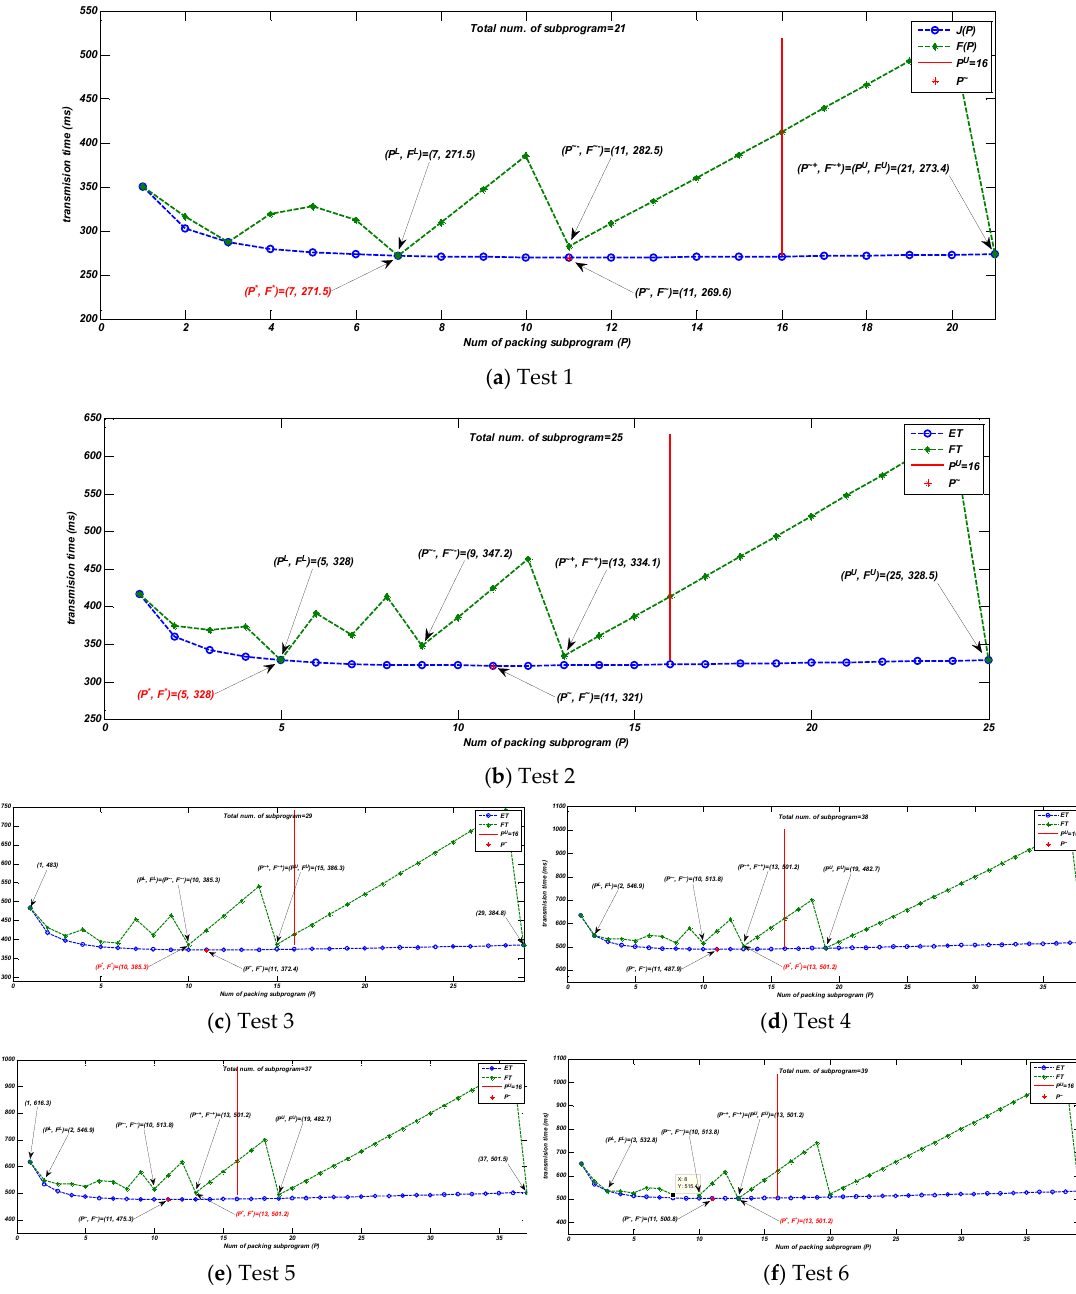
Figure 4. Optimized packet size on the lower bound and saw-tooth function.